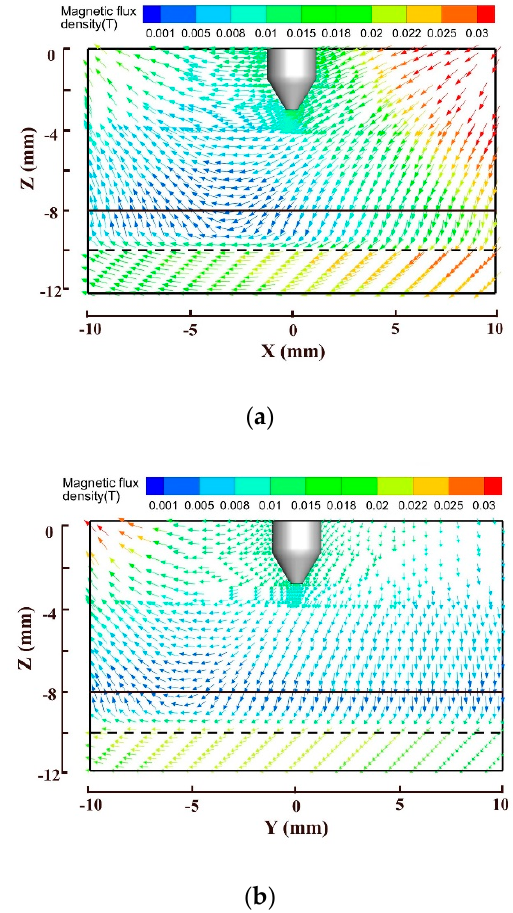
Figure 9. EMF distributions when coil 1 is energized: ( a ) xoz and ( b ) yoz planes.